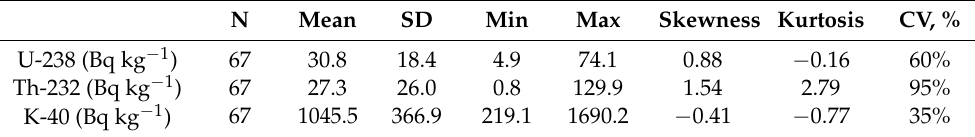
Table 2. Descriptive statistics of studied